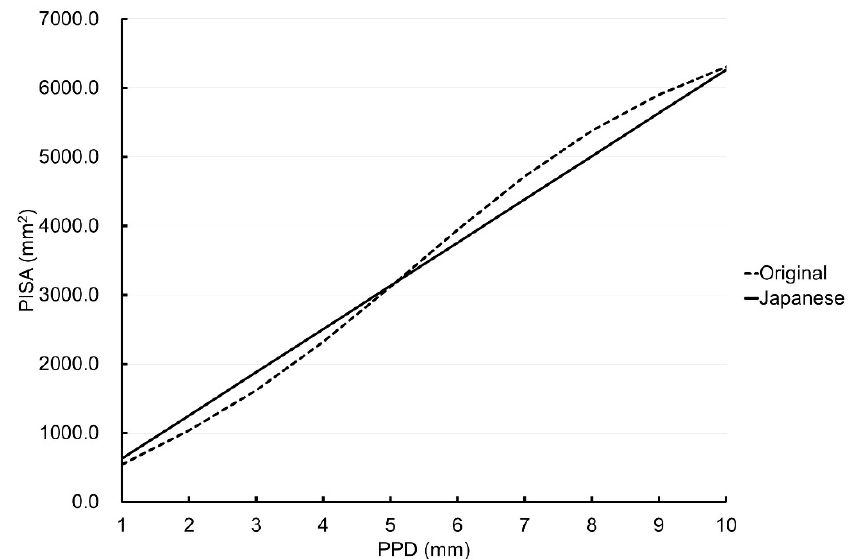
Figure 3. Simulated periodontal epithelial surface area (PISA) for probing pocket depths (PPDs) of 1 to 10 mm with bleeding on probing positivity at all six sites around the tooth in the Japanese version (solid lines) and original version (dotted lines) [1] in the whole mouth except the third molars.